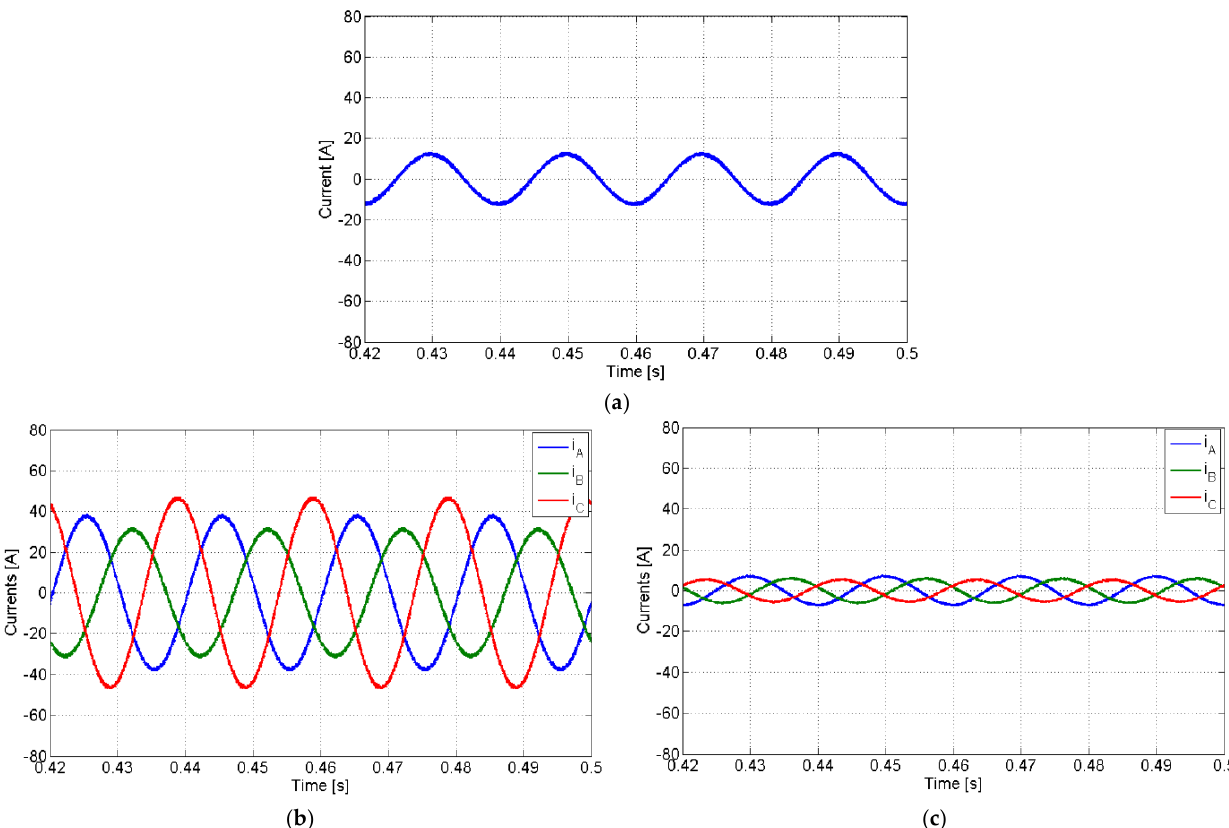
Figure 11. Simulation results with the PV generator in full compensation mode with a linear load and compensation of the active power imbalance: ( a ) current in the in the line between the fourth leg of the inverters; ( b ) AC currents of the PV generator; ( c ) grid currents.